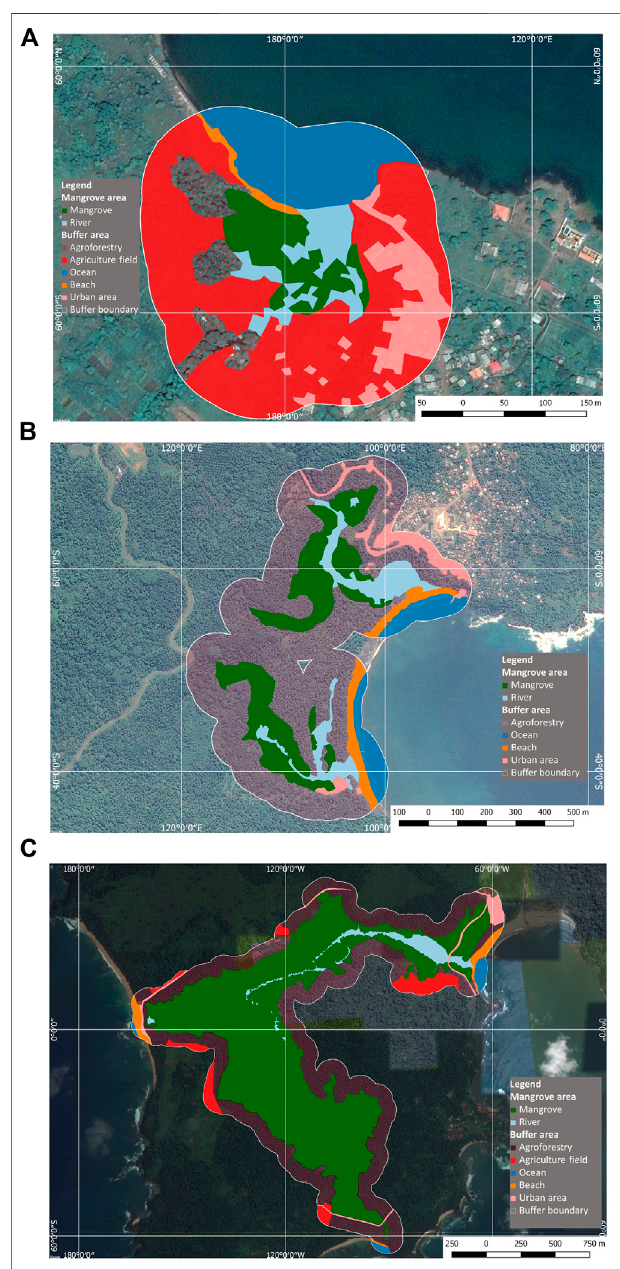
FIGURE 2 | Map of studied mangroves and 100m buffers: (A) Diogo Nunes, (B) Angolares, and (C) Malanza (image sources: Google Images, 2018; Digital